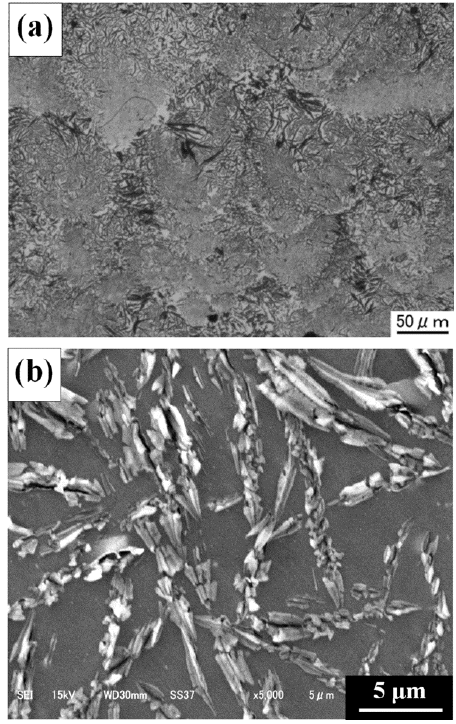
Figure 14. Enlarged ( a ) OM and ( b ) SEM images of a vertical plane of the Cu plated C/Al SLM composite.